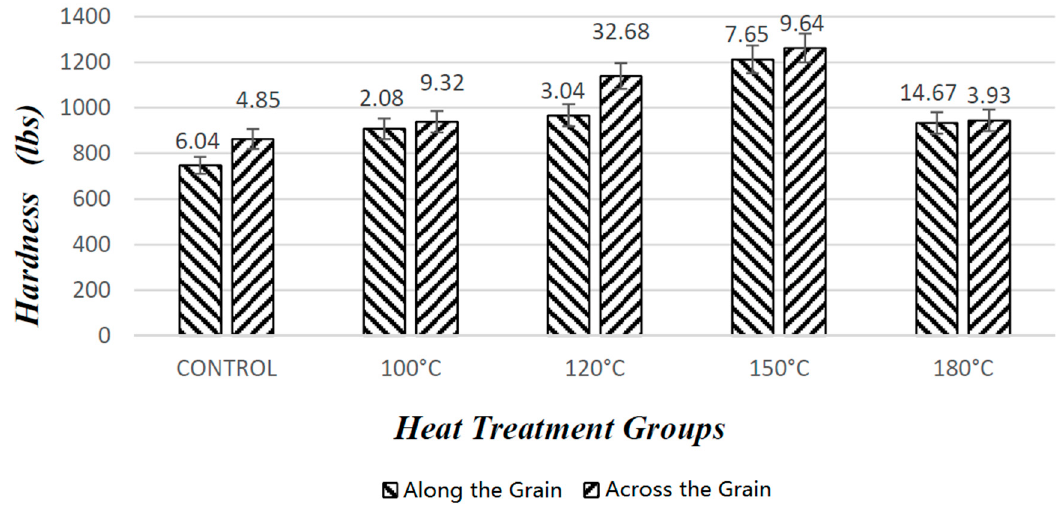
Figure 12. Hardness values of the samples after the densification process.